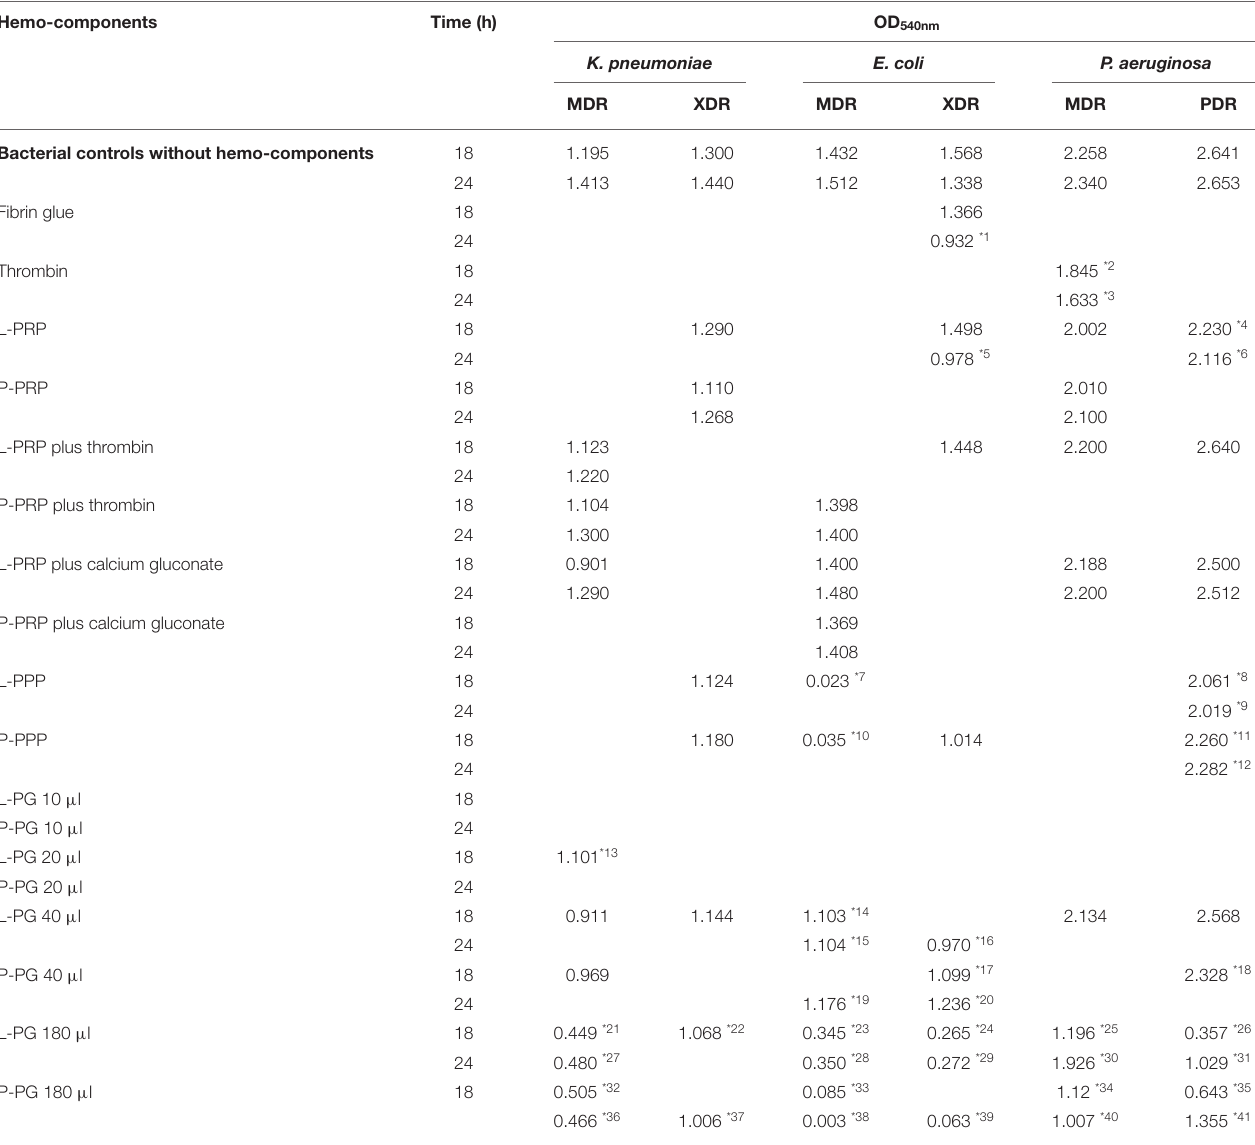
TABLE 5 | OD 540nm reductions in Gram-negative bacteria (mean OD 540nm bacterium plus hemo-component vs. mean OD 540nm bacterial control) recorded after 18 and 24h of incubation by the broth microdilution method. Hemo-components